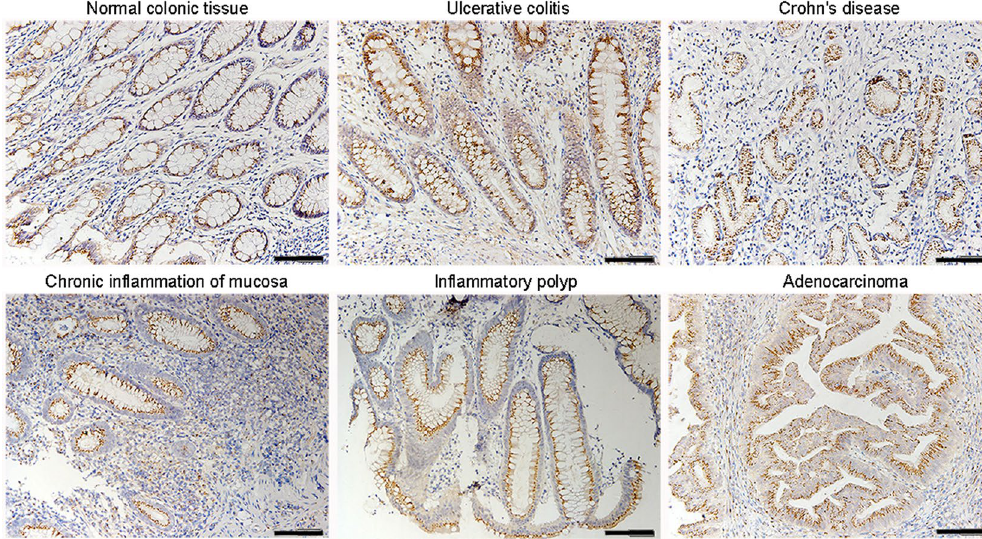
Figure 3. PSMP was expressed in the colonic inflammatory and adenocarcinoma tissues. PSMP expression was detected in the normal colonic, ulcerative colitis, Crohn’s disease, chronic inflammation, inflammatory polyp and adenocarcinoma via IHC with rabbit anti-PSMP antibody (5 μ g/mL), scale bar = 100 μ m. The colon specimens of each indicated disease were from 4~10 different